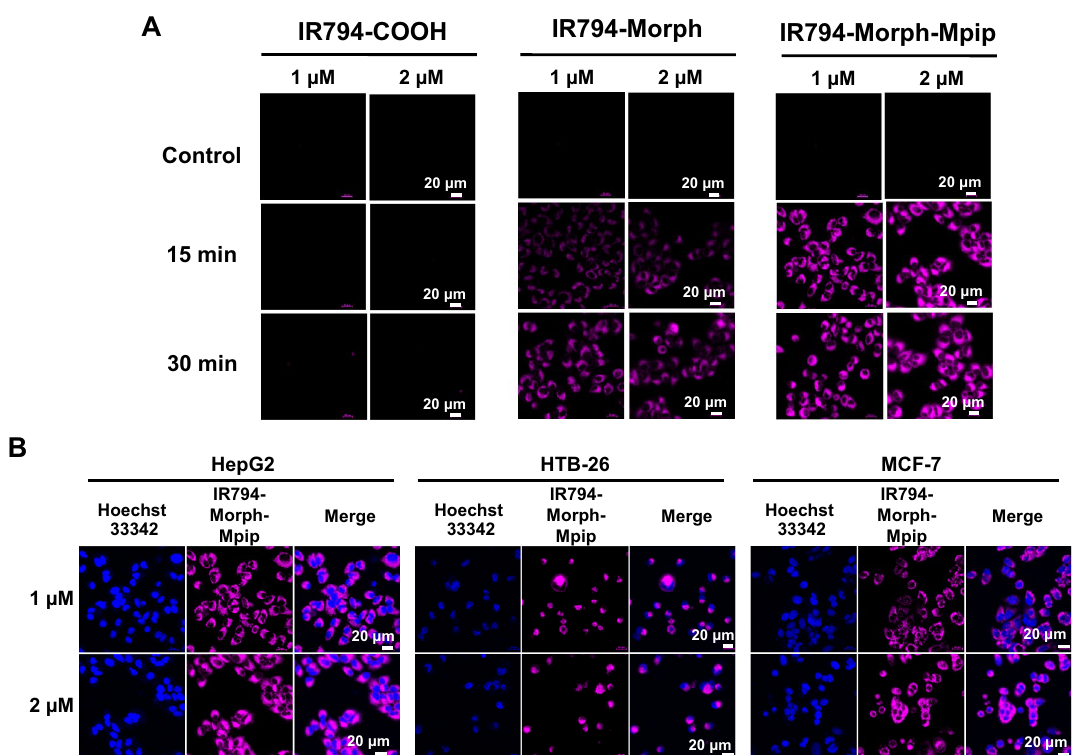
Figure 7. ( A ) Confocal images of dose-dependent effect of IR794 (1 and 2 µM) in HepG2 cells, which were incubated for 15 and 30 min. ( B ) Confocal images of cancer cells (HepG2, HTB-26 and MCF-7) after treated with IR794-Morph-Mpip (1 and 2 µM) for 15